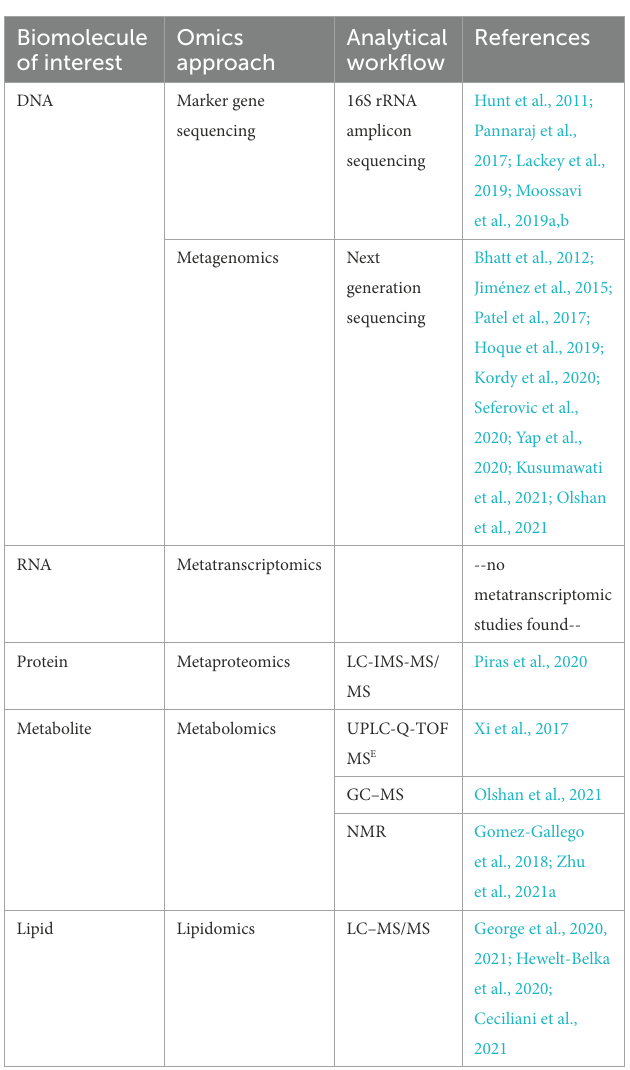
TABLE 1 List of milk microbiome related omics references cited in this